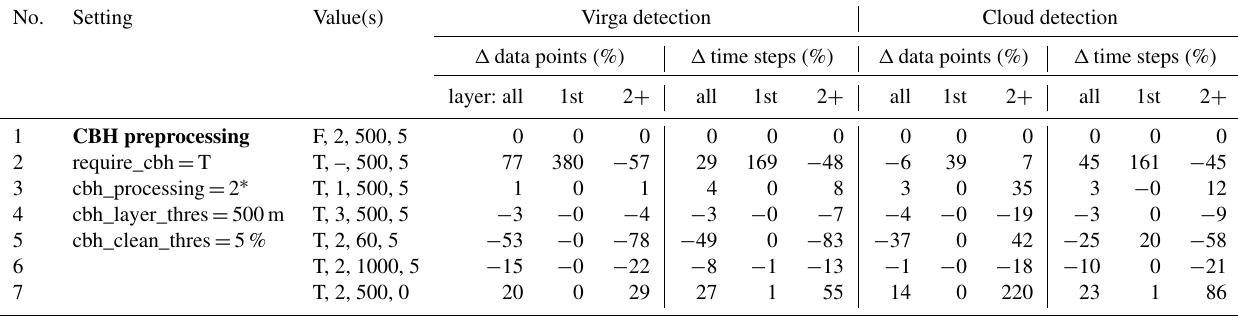
Table B1. Effects of different thresholds and settings related to the CBH of the Virga-Sniffer on the EUREC 4 A data set. The values shown refer to the deviation (%) of the total number of data points/time steps which are identified as virga/cloud to the total number of data points/time steps using the default setting. The total number of data points includes both changes in virga depth and time steps with virga. Defaults and respective test value of the setting or threshold are indicated in the first and second columns (true = T, false = F). No. Setting